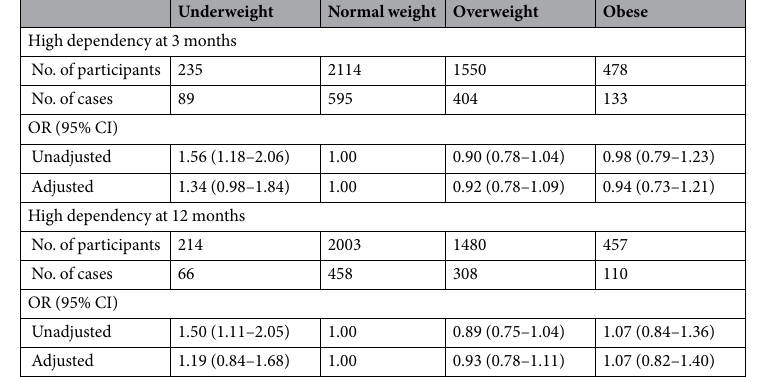
Table 3. Body mass index related to risk for high dependency in surviving patients. CI, confidence interval; OR, odds ratio. The adjusted analyses included the following covariates: age, sex, living partnership, education level, annual household income, medical history of hypertension, diabetes, hyperlipidaemia, atrial fibrillation, prior stroke or TIA, coronary artery disease, and prior dependency, current smoking status, regular alcohol consumption, time of presentation to hospital, Glasgow Coma Scale score on admission and Oxfordshire Community Stroke Project classification on admission.